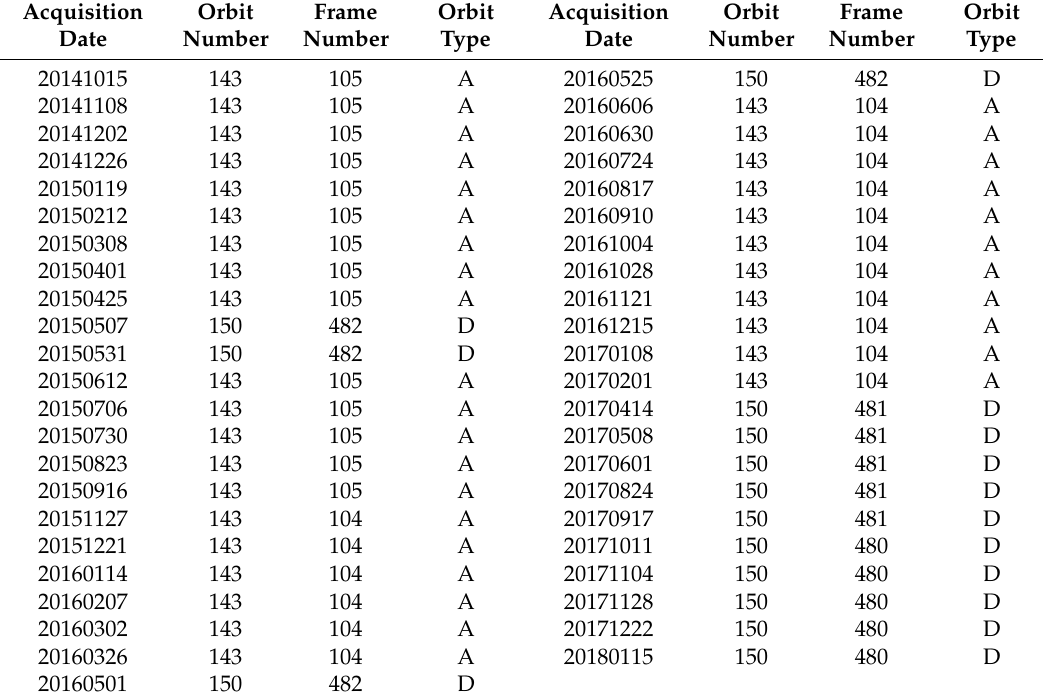
Table 1. The Sentinel-1A C-band SAR datasets used in this